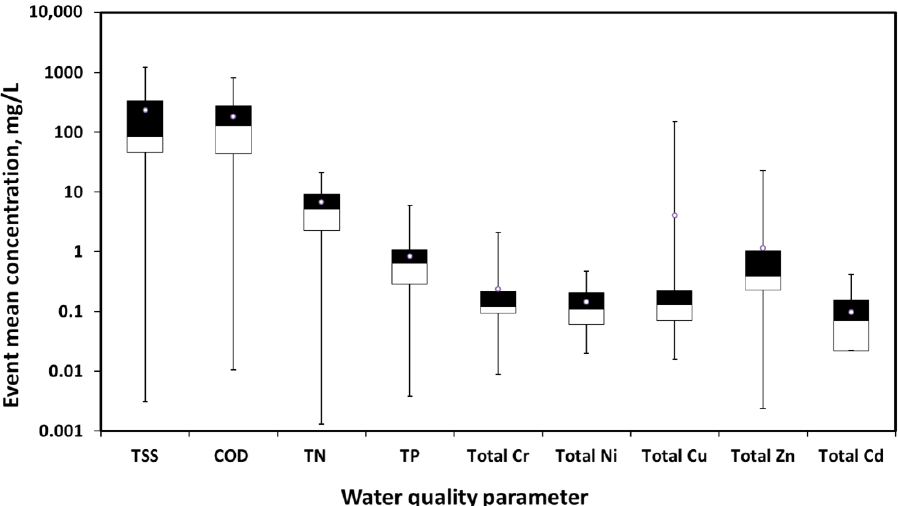
Figure 3. Event mean concentrations of the pollutants in the influent.